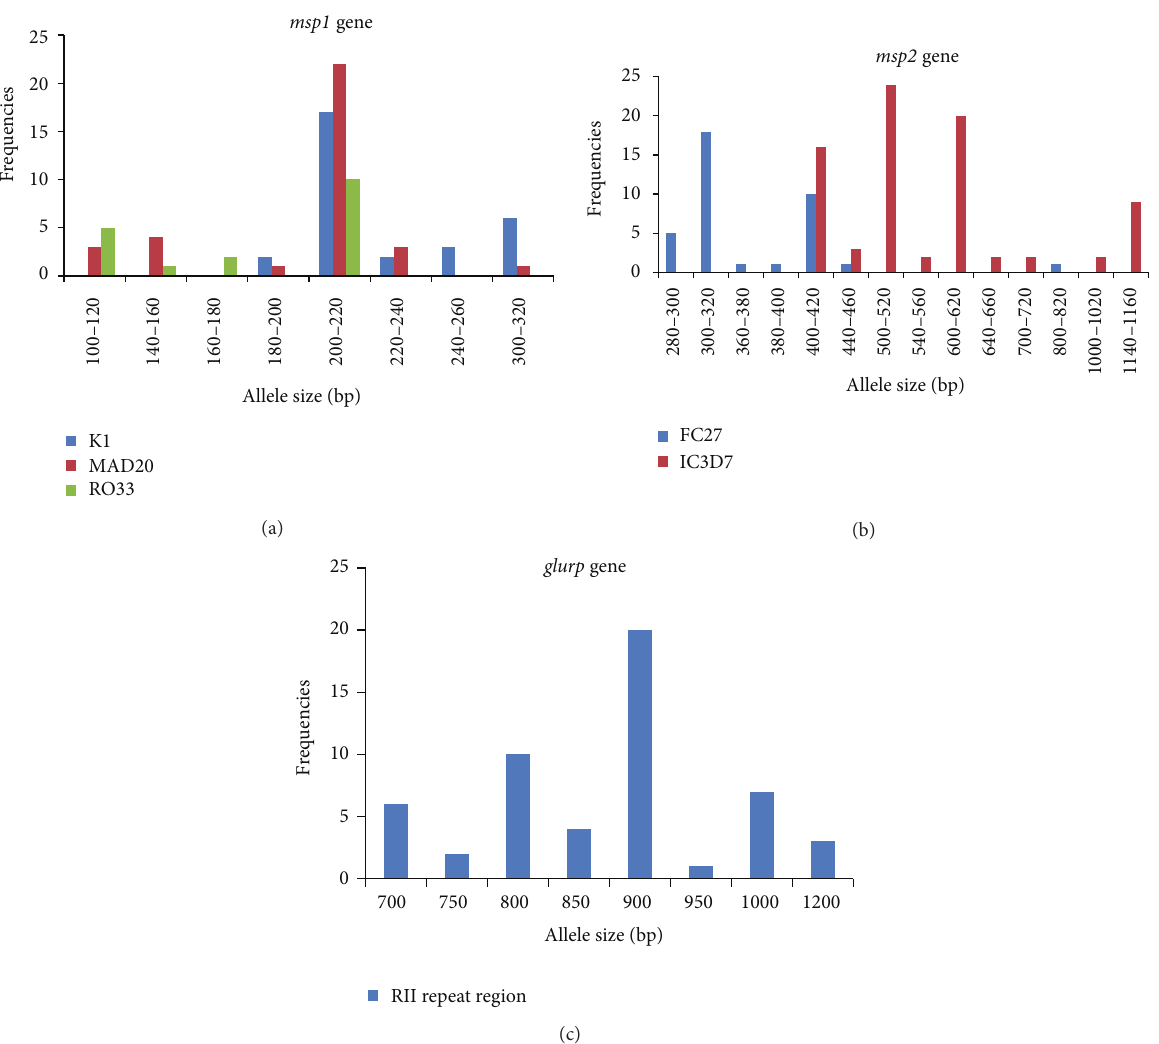
Figure 3: Genetic diversity of P. falciparum by msp1 , msp2 , and glurp genes. PCR amplification was represented by groups where PCR product size differed by 20 bp. (a) Genetic diversity by msp1 gene. Blue bars denote the K1 allelic family, size ranging from 180 to 300 bp; red bars denote the MAD20 allelic family, size ranging from 100 to 220 bp; and green bars denote the RO33 allelic family, size ranging from 100 to 200 bp. (b) Genetic diversity by msp2 gene. Blue bars denote the FC27 allelic family, size ranging from 280 to 800 bp and the red bars denote the IC3D7 allelic family, size ranging from 400 to 1150bp. (c) Genetic diversity by glurp gene. Blue bars denote the RII repeat region of glurp gene, size ranging from 700 to 1200